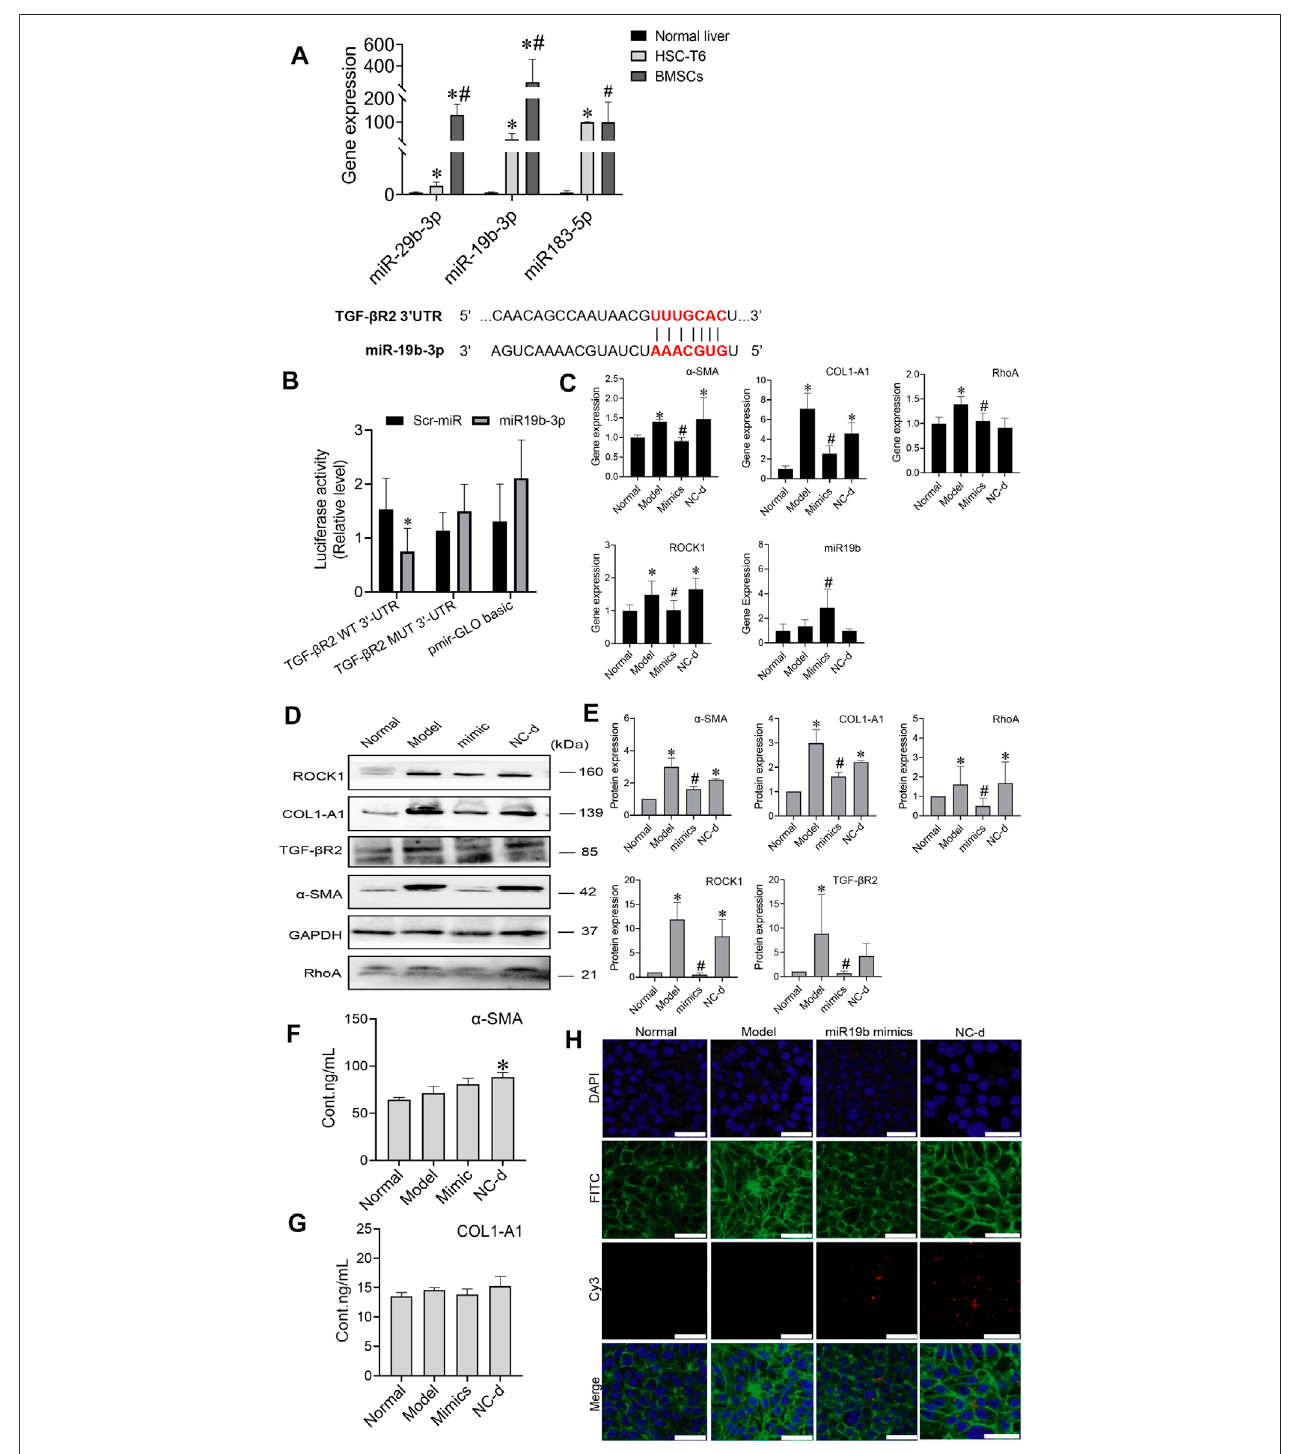
FIGURE 6 | MiR-19b-3p derived from BMSCs inactivates HSCs by suppressing the expression of its target TGF- β R2. (A) The potential binding site (red fonts) of miR-19b-3p was predicted in the 3 ′ UTR of TGF- β R2 mRNA in rats. The dashed line represents complementary base pairs between miR-19b-3p and TGF- β R2 mRNA. (B) A dual-luciferase assay was performed to verify the binding interaction between miR-19b-3p and TGF- β R2 mRNA. Cells cotransfected with pmirGLO basic vector containing either wild-type (WT) or mutant (mut) target sites plus either the miR-19b-3p mimic or scrambled (Scr-) miR (control); (C) qRT-PCR analysis for α -SMA, COL1-A1, ROCK1, and RhoA in HSCs. n = 3 independent experiments, one-way ANOVA; * p < 0.05 versus the normal group; # p < 0.05 versus the model group; (D , E) Western blot bands and cumulative densitometric analyses of each group (normal, model, mimic, NC-d). Data are presented as the mean ± SEM ( n = 3